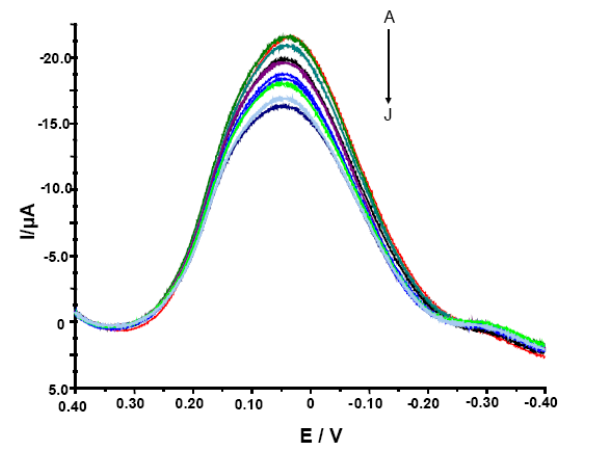
Figure 2. The OSWV curves for electrodes modified with SWCNT/Hb measured in the presence of various concentrations of acrylamide. The electrolyte composition: 0.05 M NaCl, 0.2 M acetate buffer pH = 5.0. The concentration of analyte was, as follows: (A) 0, (B) 1.0 × 10 –11 , (C) 1.0 ×10 –10 , (D) 1.0 × 10 –9 , (E) 1.0 × 10 –8 , (F) 1.0 × 10 –7 , (G) 1.0 × 10 -6